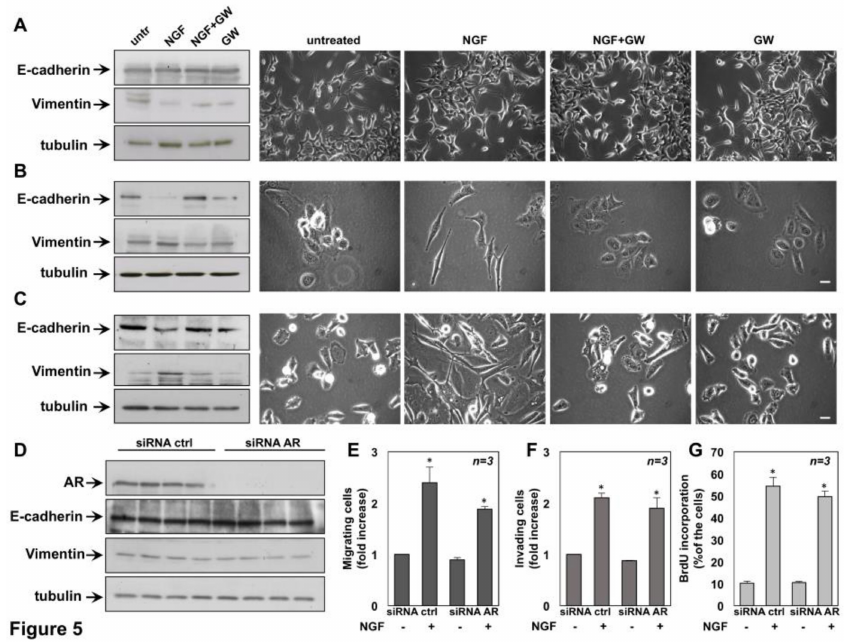
Figure 5. Nerve growth factor (NGF) promotes epithelial-mesenchymal transition (EMT) in DU145 and PC3 cells and silencing of Androgen Receptor (AR) does not affect EMT, migration, invasiveness and DNA synthesis of NGF-treated C4-2B cells. Quiescent C4-2B ( A ), DU145 ( B ) and PC3 ( C ) cells were left untreated or treated for 72h with the indicated compounds. NGF was used at 100ng / mL and GW441756 (GW) at 1 µ M. In A-C (left panels), protein lysates were analyzed by Western blot, using the antibodies against the indicated proteins. The blots are representative of three different experiments. In A-C (right panels), Phase-contrast images are representative of 3 different experiments, each in duplicate. Scale bar, 10 µ m in A and 90 µ m in B and C . In D-G, C4-2B cells were transfected with AR siRNA or control siRNA, as reported in Methods. After transfection, the cells were made quiescent and then left un-stimulated or stimulated as reported. In D , cells were stimulated as in A and protein lysates were analyzed by western blot using the antibodies against the indicated proteins. Cells were used for migration ( E ) and invasion ( F ) assays in Boyden’s chambers pre-coated with collagen or Matrigel, respectively. The indicated compounds were added to the upper and the lower chambers. After 7 h (in E ) or 24 h (in F ), migrating or invading cells were counted as reported in Methods. In G , transfected C4-2B cells on coverslips were left untreated (untr) or treated for 18h with the indicated compounds. After in vivo pulse with 100 µ M BrdU, BrdU incorporation was analyzed by immunofluorescence (IF) and expressed as % of total cells. In E – G , the cells were co-transfected with siRNA Alexa Fluor 488 to help identification of transfected cells. Results from three different experiments were collected and expressed as fold increase. Means and standard error of the means (SEMs) are shown. n represents the number of experiments. * p < 0.05 for the indicated experimental points vs. the corresponding untreated